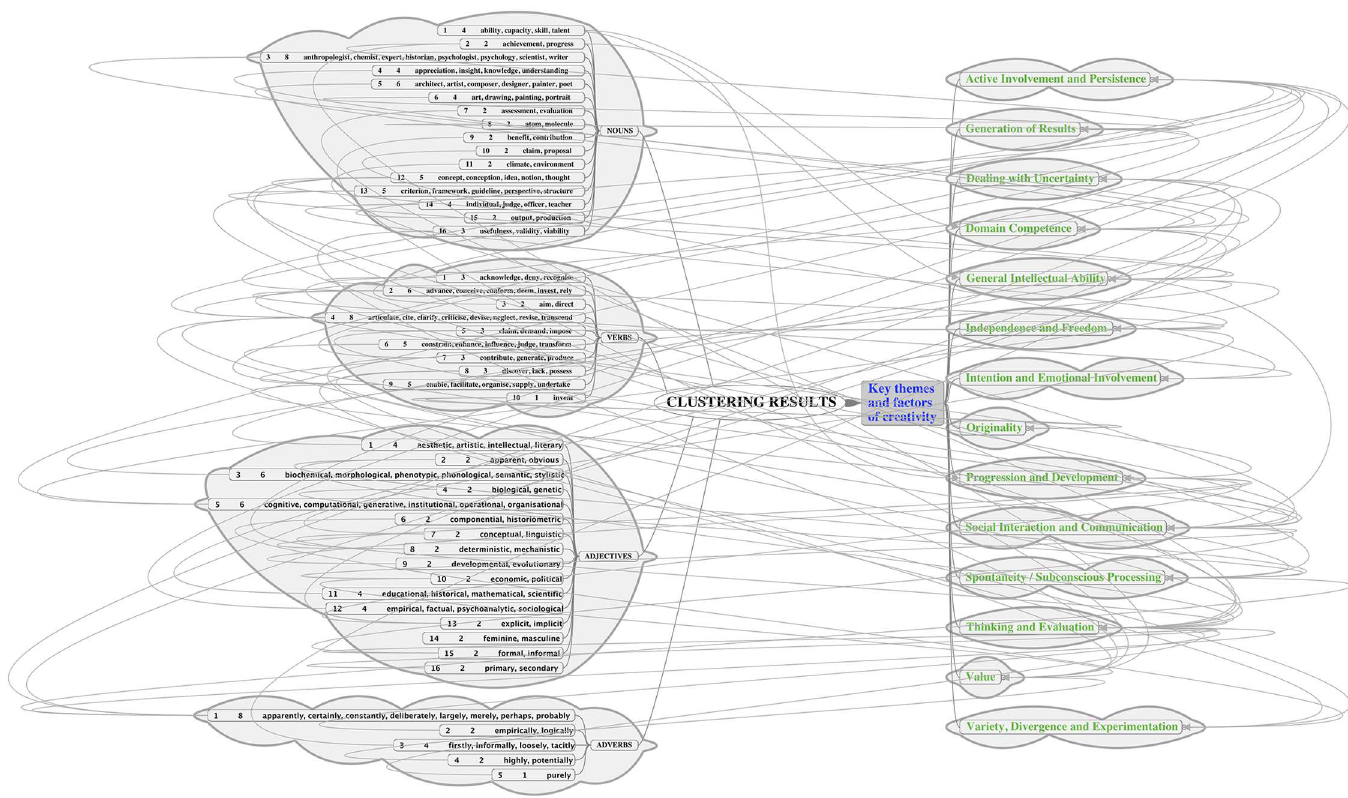
Fig 6. Illustration of the process of using manual inspection for further